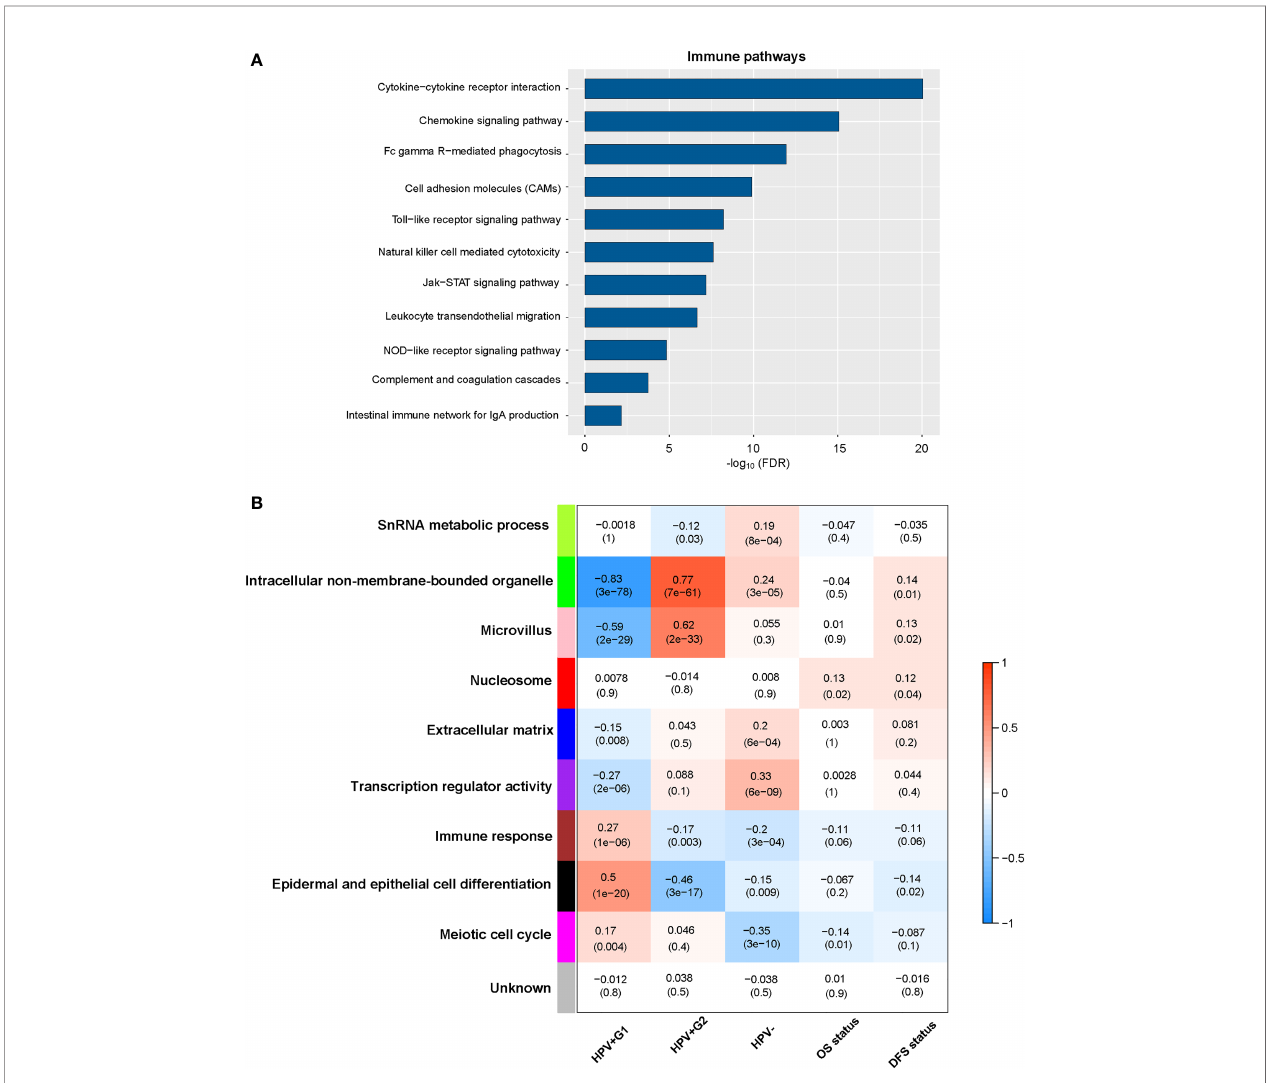
FIGURE 3 | Pathways and gene ontology (GO)enriched in the HPV+ cervicalcancer subtypes. (A) The immune-related pathways enrichedin HPV+G1 versusHPV+G2. (B) Nine gene modules and their representative GO terms signi fi cantly differentiatingcervical cancersbysubtypeand survival.OS, overallsurvival; DFS, disease-free